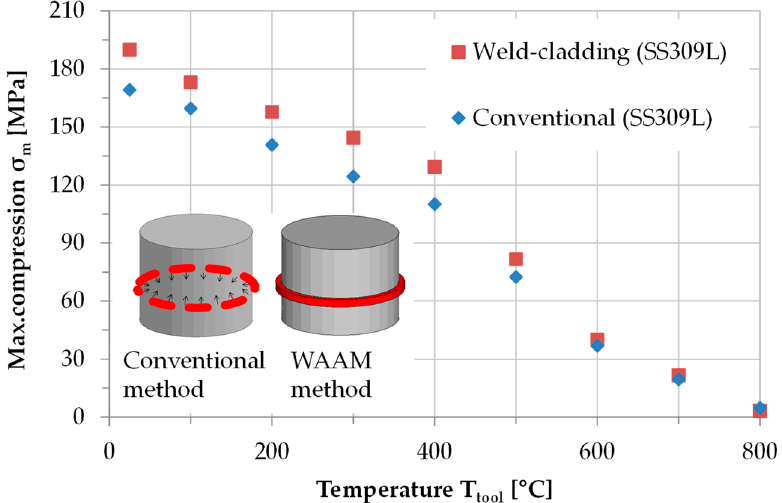
Figure 28. Maximum compressive stresses (reinforcement) on the tool surface, achieved at different operating conditions of the extrusion tool.